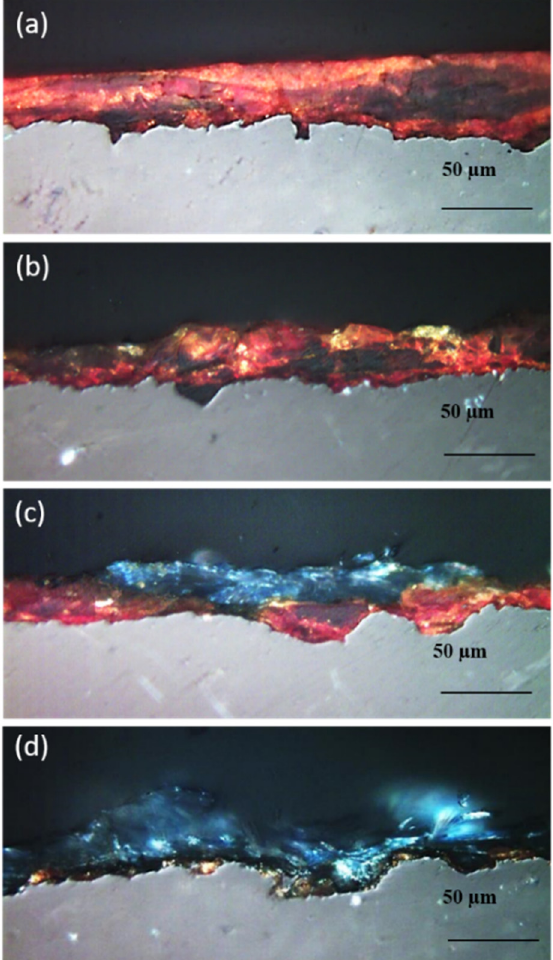
Figure 2. Optical microscope images of untreated ( a ), two different zones of the abiotic control ( b , c ), and bacterially treated ( d ) iron coupons.